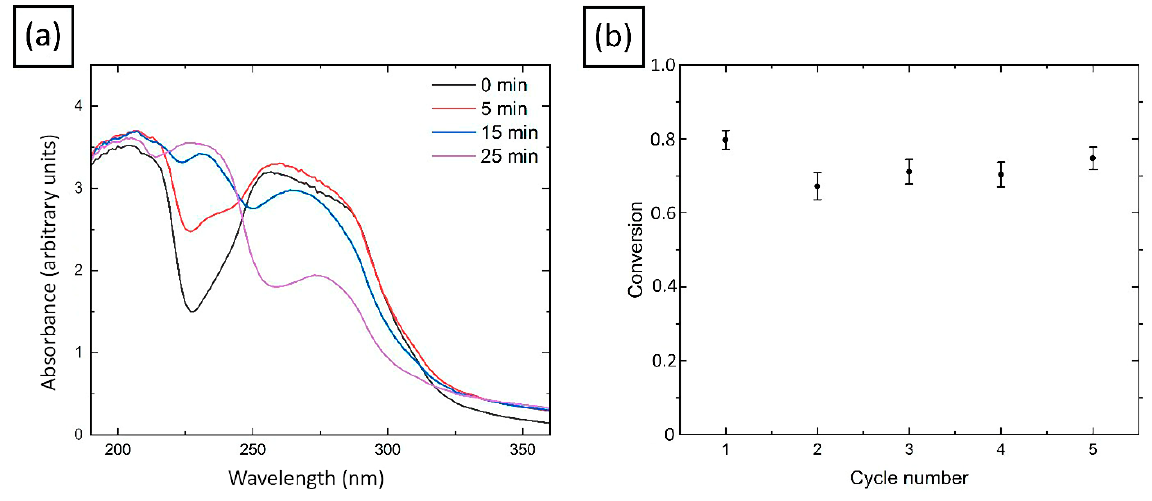
Figure 10. ( a ) UV-vis spectra of nitrobenzene aqueous solution in the presence of NaBH 4 with Cu/CS catalyst; ( b ) Reusability of Cu/CS catalyst for the nitrobenzene reduction to aniline.